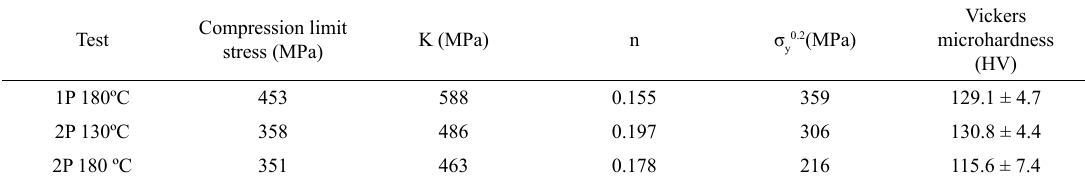
Figure 5. True Stress-strain curve of uniaxial compression test to analyzed conditions. Table 2. Material mechanical